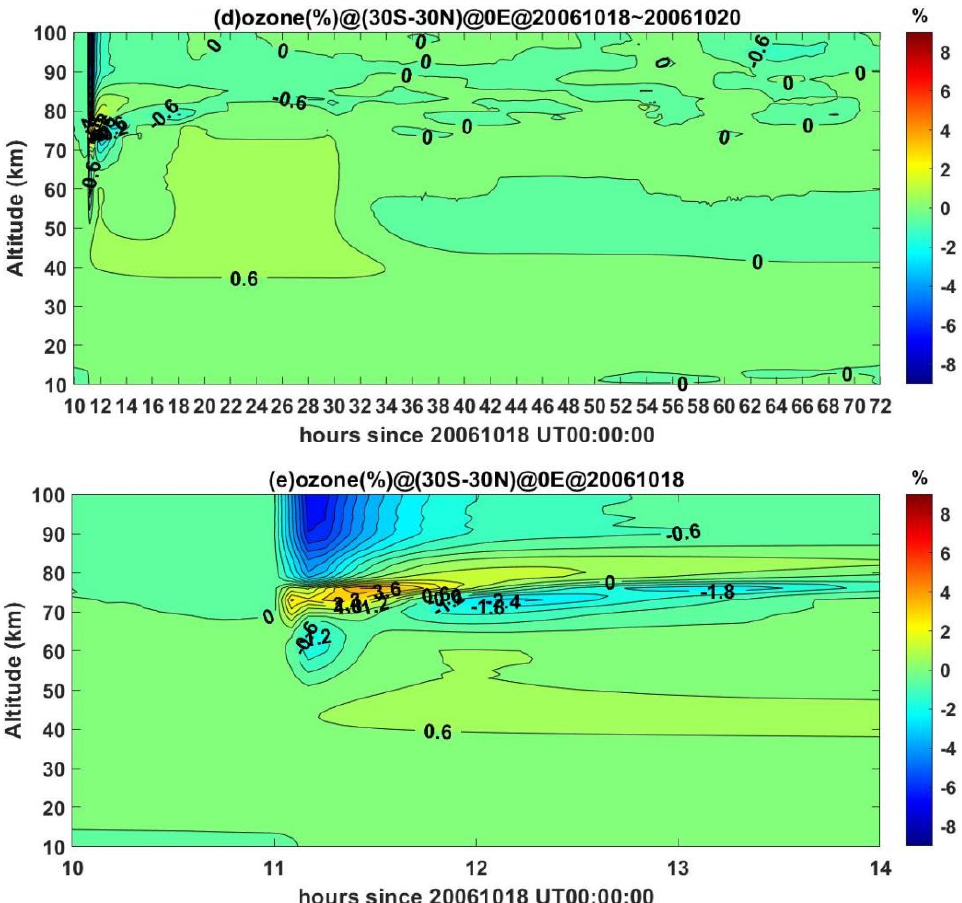
Figure 4. Difference in atmospheric ozone between flare simulation and baseline simulation. (( a – e ) flare simulation minus baseline simulation).